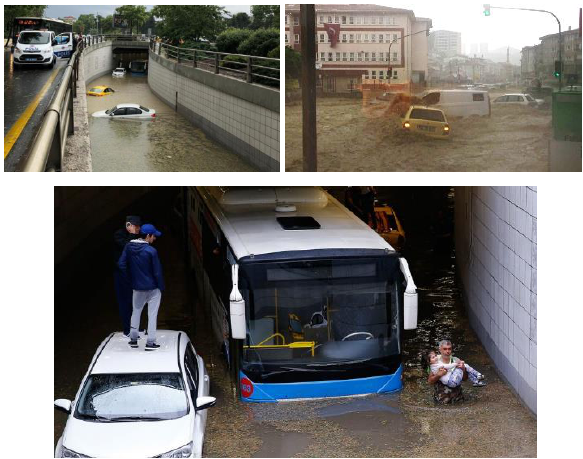
Figure 2. Examples to damages after May 5 th flood in Ankara (photo credits: http://www.cumhuriyet.com.tr, www.ntv.com.tr, www.aa.com.tr – accessed on September 25 th , 2018).